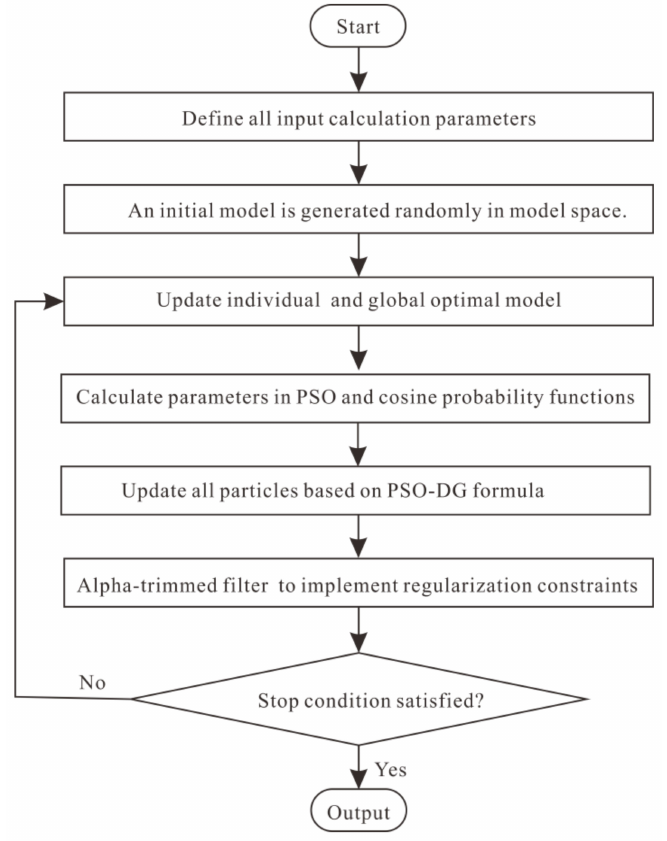
Figure 2. Flowchart of the PSO-GD algorithm.